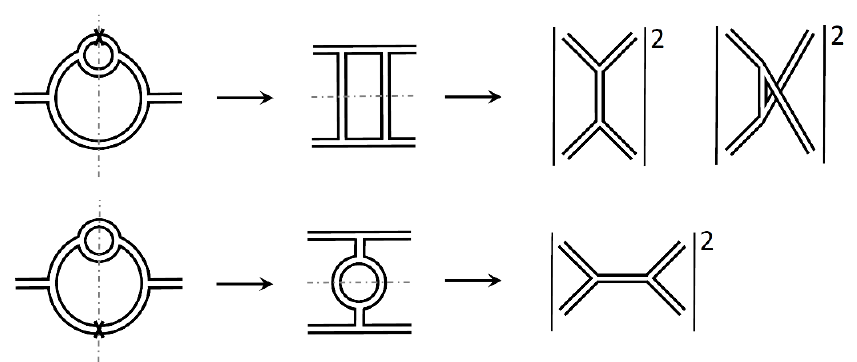
Figure 6 . The procedure of opening one line of the two-loop self-energy to reproduce rungs. The dashed line is the cutting line and the cross denotes the open line. The last column shows the scattering processes corresponding to the rungs shown.